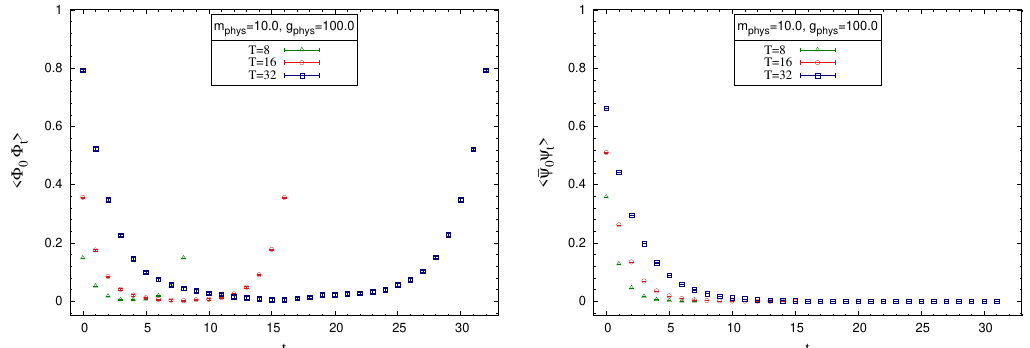
Figure 2 . Bosonic (left) and fermionic (right) correlation functions for SUSY anharmonic oscillator. The parameters used are m phys = 10 and g phys = 100 .